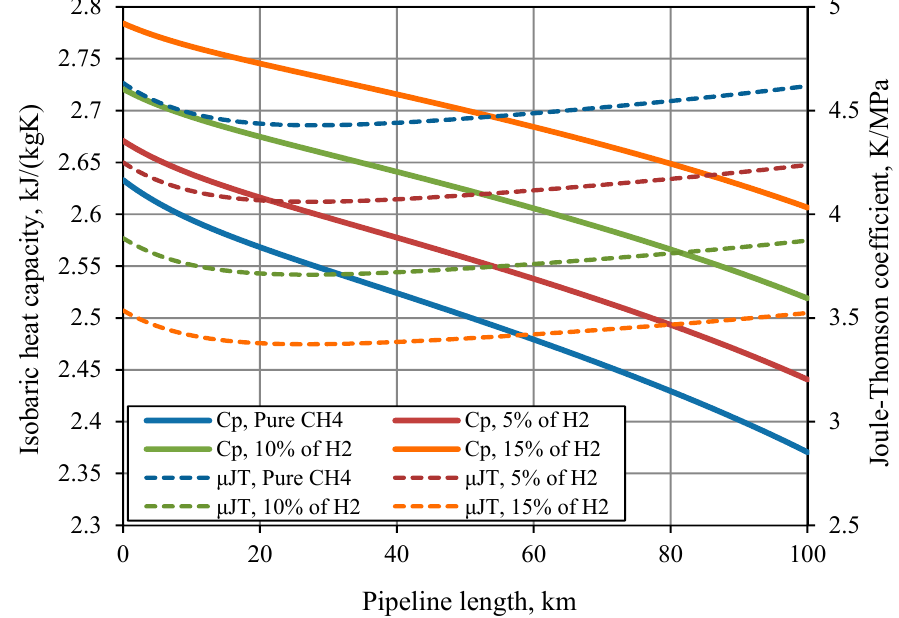
Figure 17. Isobaric heat capacity ( Cp ) (continuous lines) and Joule–Thomson coefficient ( μ JT ) (dashed lines) changes as a function of hydrogen content and pipeline length.